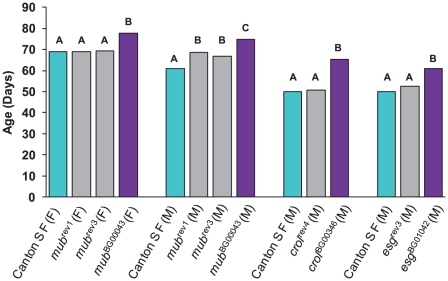
Analysis of revertant alleles.M denotes males and F denotes females. Canton S F control genotypes are depicted in cyan, and mub
BG00043, crol
BG00346 and esg
BG01042 genotypes in dark pink. Grey bars denote the revertant genotypes mub
rev1 (precise), mub
rev3 (imprecise), crol
rev4 (precise) and esg
rev3 (precise). The letters indicate the results of Tukey tests for significant differences between control, mutant and revertant lines. Genotypes with the same letter are not significantly different from each other.